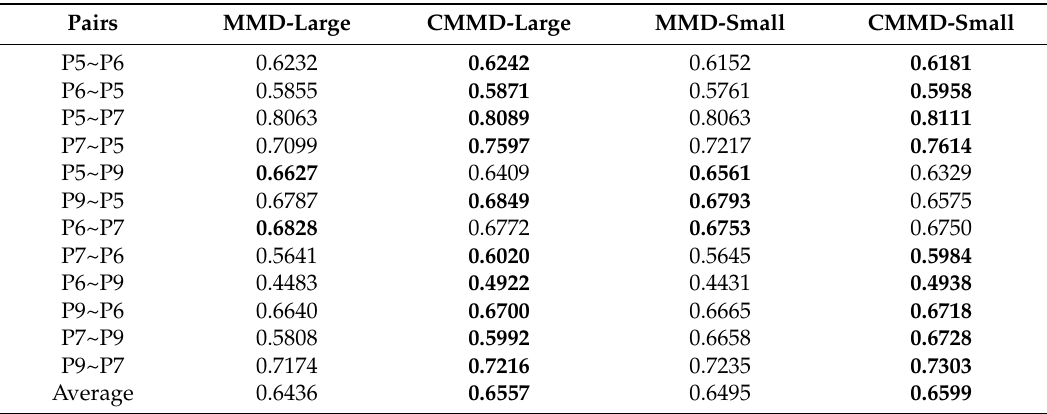
Table 9. Experiment result of CMMD on USC. Large indicates that the Target uses more unlabeled data under the experimental conditions shown in Table 6. Small indicates that the Target uses less unlabeled data under the experimental conditions shown in Table 7.